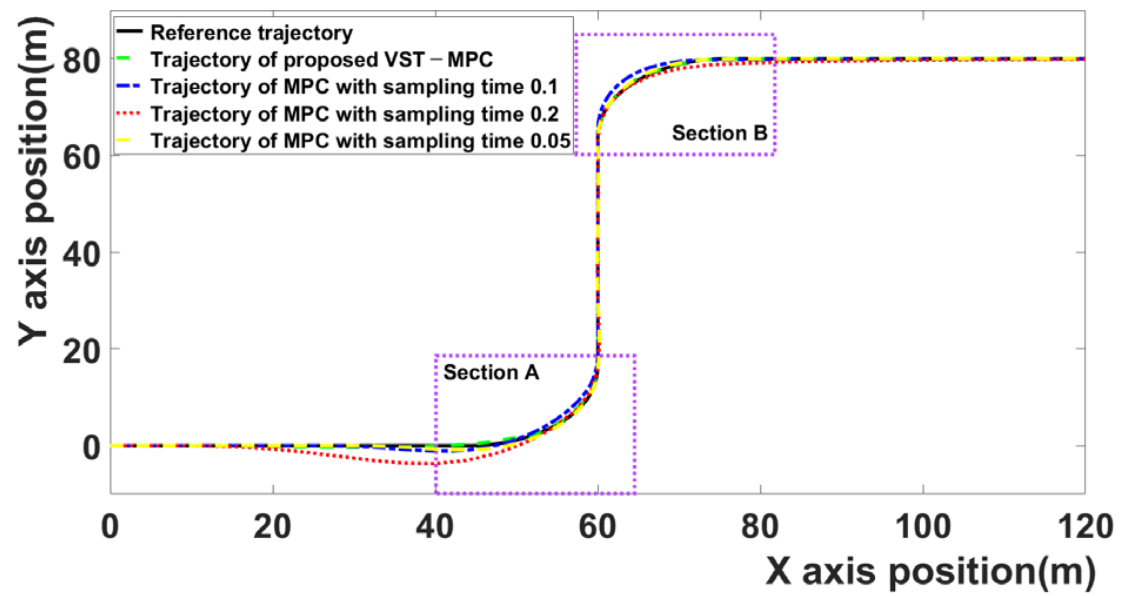
Figure 4. Comparison of trajectories of four MPC algorithms.